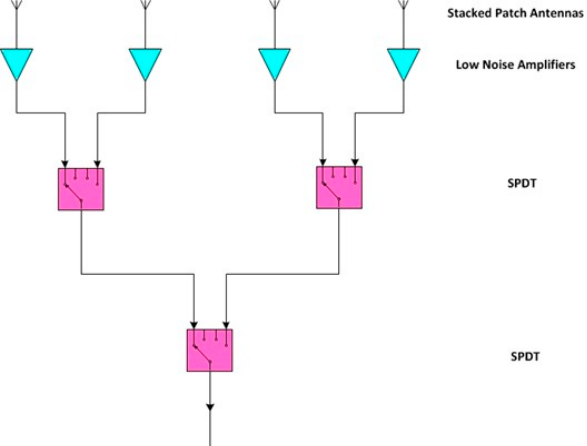
Figure 9. Receiving antenna module block diagram.